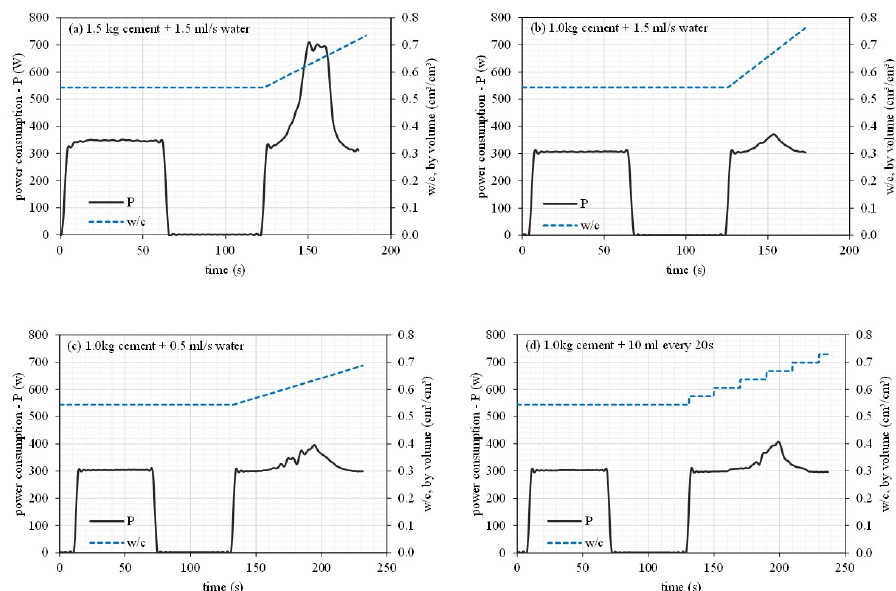
Figure 7. Mixing energy test results with a water addition rate of: (a) 1.5 ml/s with 1.5 kg of cement, (b) 1.5 ml/s with 1.0 kg of cement, (c) 0.5 ml/s and (d) 10 ml every 20